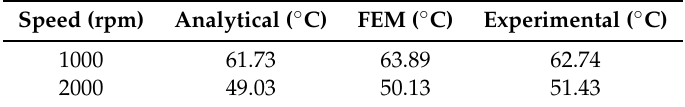
Table 3. Winding temperature validation.